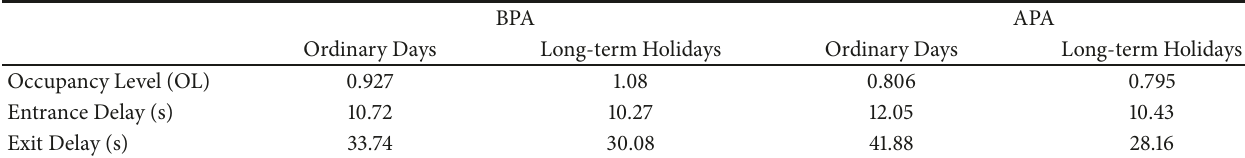
Table 4: Statistical results of the QOS parameters before and after price